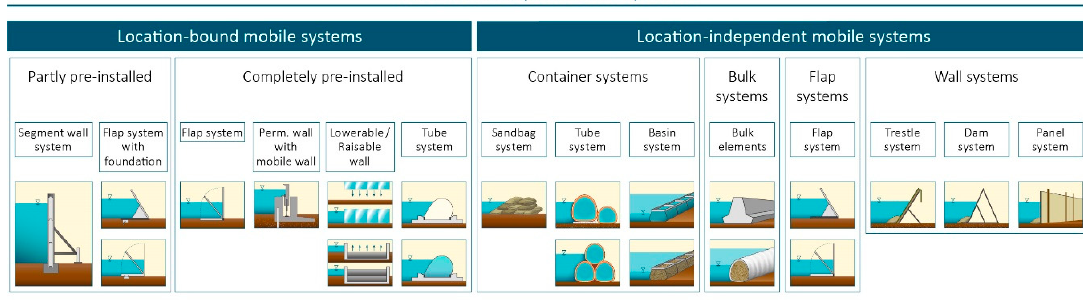
Figure 1. Classification of mobile flood protection systems.